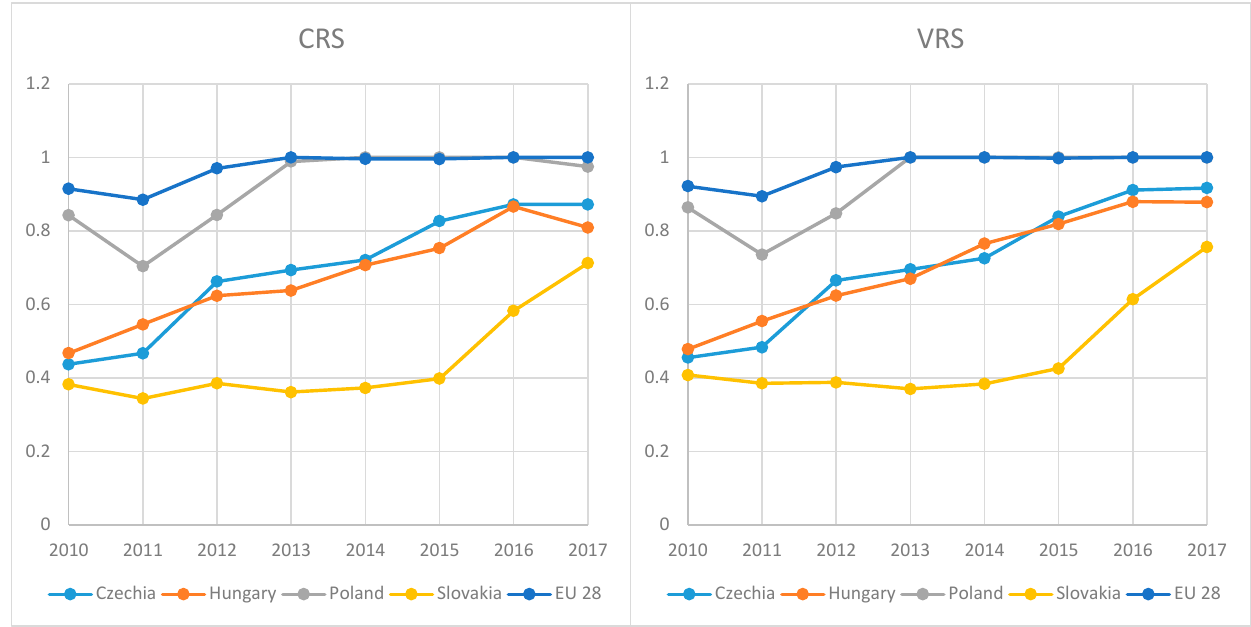
Figure 1. Circular efficiency results of V4 countries compared to EU 28 average.